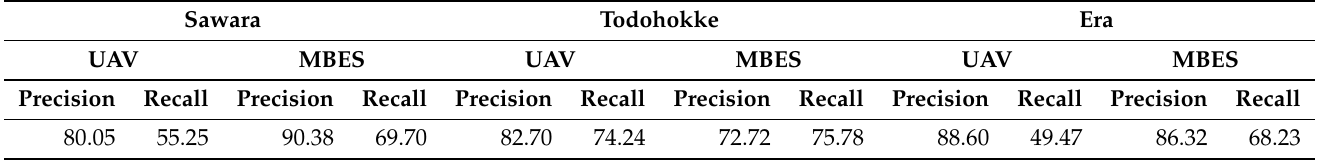
Table 2. Performance of instance segmentation on blocks in three ports. Metrics are precision (%) and recall (%) with an IoU threshold of 0.5. The UAV point cloud was measured from real-world scenes, and ground truth segmentation was performed manually, while the MEBS point cloud was